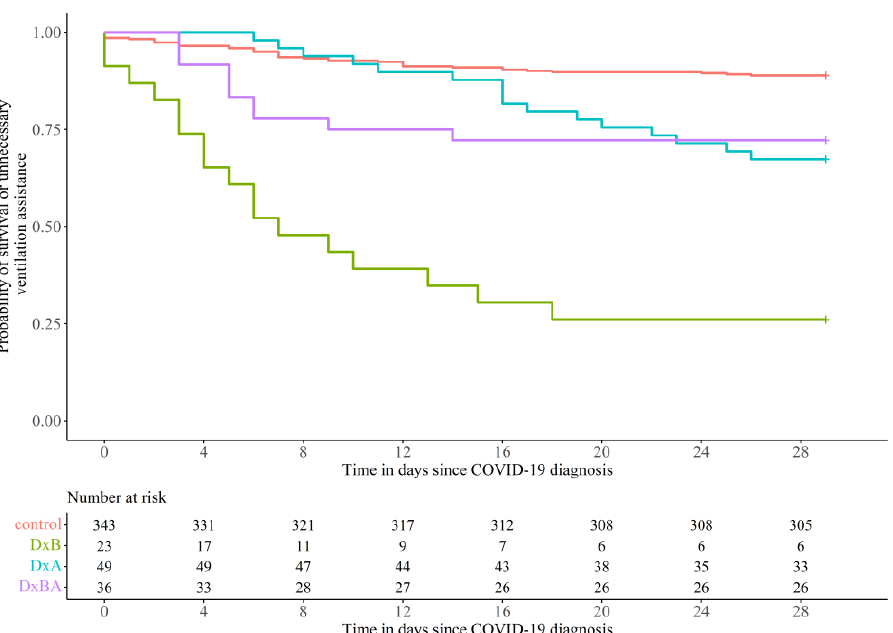
Figure 2. Kaplan–Meier curve for dexamethasone-treated patient subgroups compared to the control group. Control (Red, N = 343, events = 38), patients receiving Dexamethasone only before (DxB) COVID-19 diagnosis (Green, N = 23, events = 17), patients receiving Dexamethasone only after (DxA) COVID-19 diagnosis (Blue, N = 49, events = 16), and patients receiving Dexamethasone before and after (DxBA) COVID-19 diagnosis (Purple, N = 36, events = 10). Table 5. Hazard ratios from multivariable Cox proportional hazards